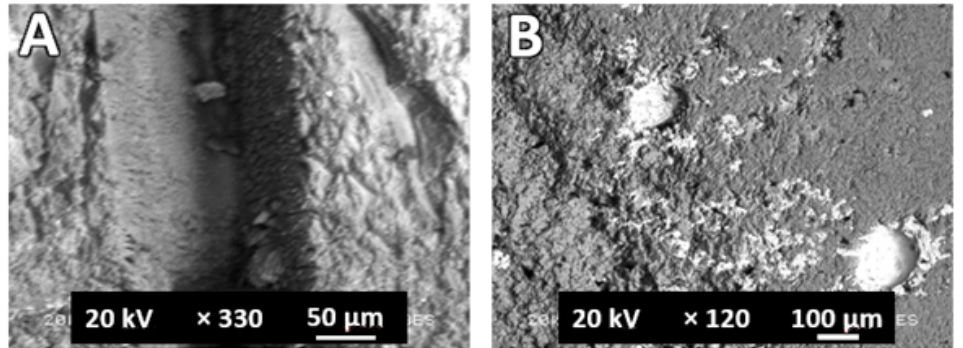
Figure 11. Clearly defined edges of the ablation spot from the Ti:Sapphire femtosecond laser on the chondritic meteorite JaH 815 ( panel A ), in comparison with a detailed picture of ejected molten Fe–Ni droplets in the vicinity of the PALS ablation crater on the chondritic meteorite NWA 8212 ( panel B ).